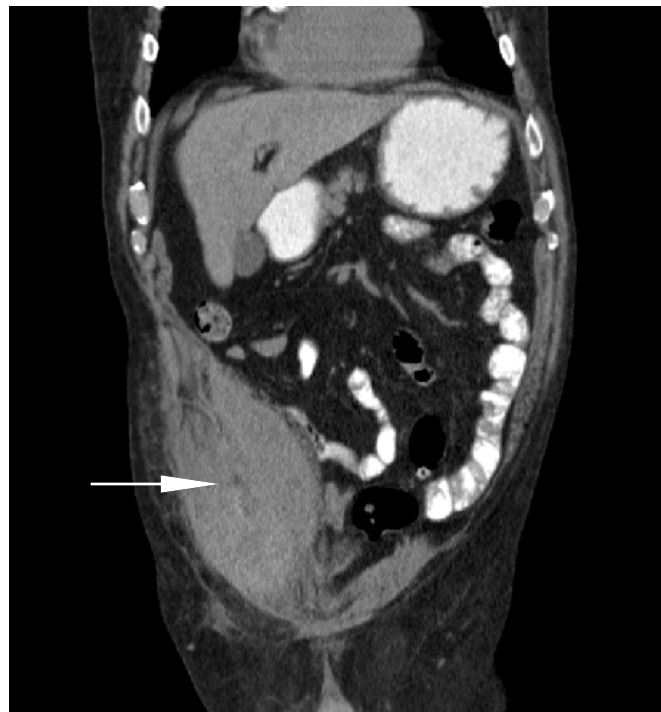
Figure 1. Axial view computed tomographic scan revealing hematoma within the rectus sheath (arrow).